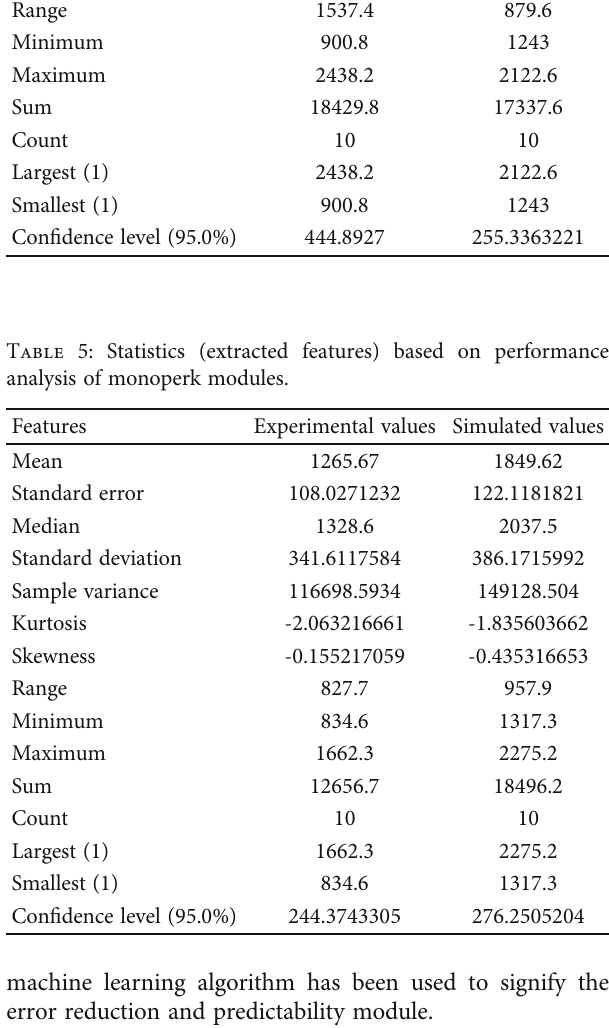
Figure 12. The baseline for the mathematical formulation of logistical regression is simple linear regression.